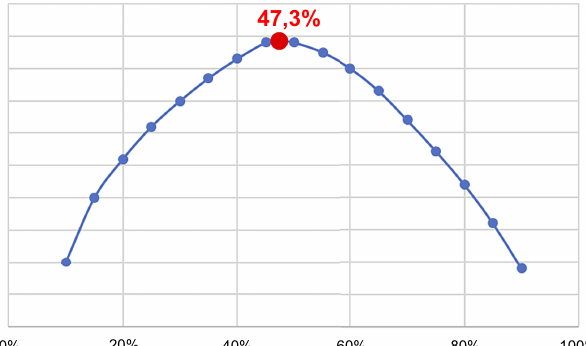
Figure 1. Optimal debt